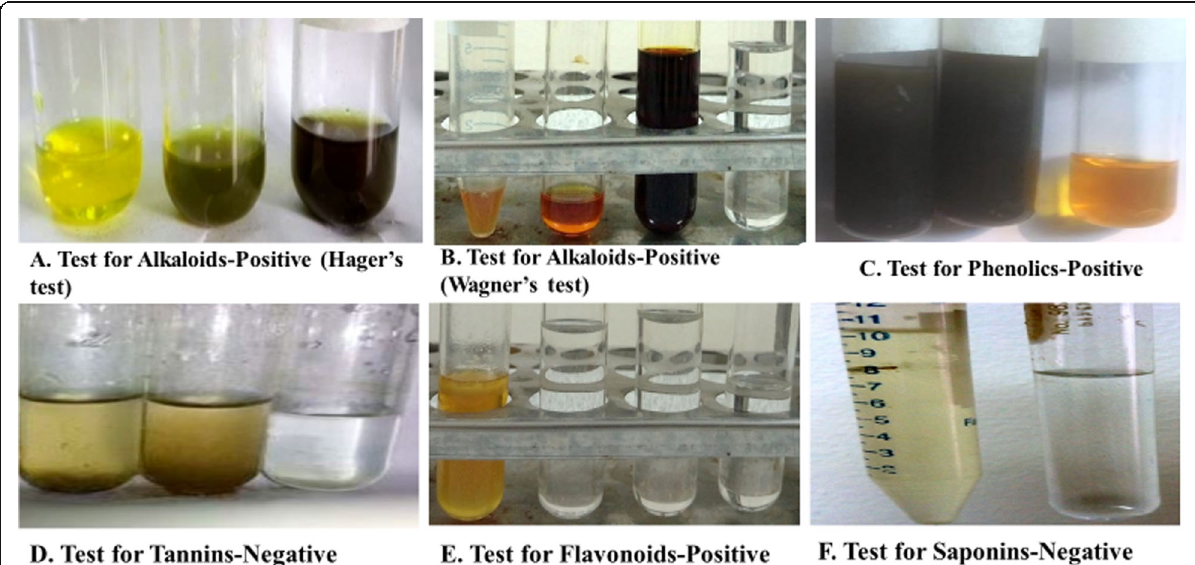
Fig. 7 Figures are showing phytochemical test results for different plant compounds. a Alkaloids (Hager ’ s test): from left to right — Hager ’ s reagent, test result, and ethanolic extract. There was a visible color change of the sample which indicates a positive result for alkaloids. b Alkaloids (Wagner ’ s test): from the left side is the test sample, Wagner ’ s reagent mixture, Wagner ’ s reagent, and ethanol. The visible color change of the sample indicates a positive result for alkaloids. c Test for the identification of phenolic compounds. From the left side, the first two are sample extracts showing the desired color change which indicate positive result and the 3rd one is the control, FeCl 3 . A dark green color indicates the presence of phenolic compounds in the sample. d Tests for tannins (lead acetate test): no yellow precipitation in the test sample indicates a negative result. e Test for flavonoids: from the left side — 1st one is test sample showing yellow color, 2nd one ethanol, 3rd one NaOH, and 4th one is the mixture of ethanol and NaOH. There was a visible color change of the sample which indicates a positive result for flavonoids. f Tests for saponins (froth test): the left one is the test sample and the other one is distilled water. No froth formed in the test sample indicates